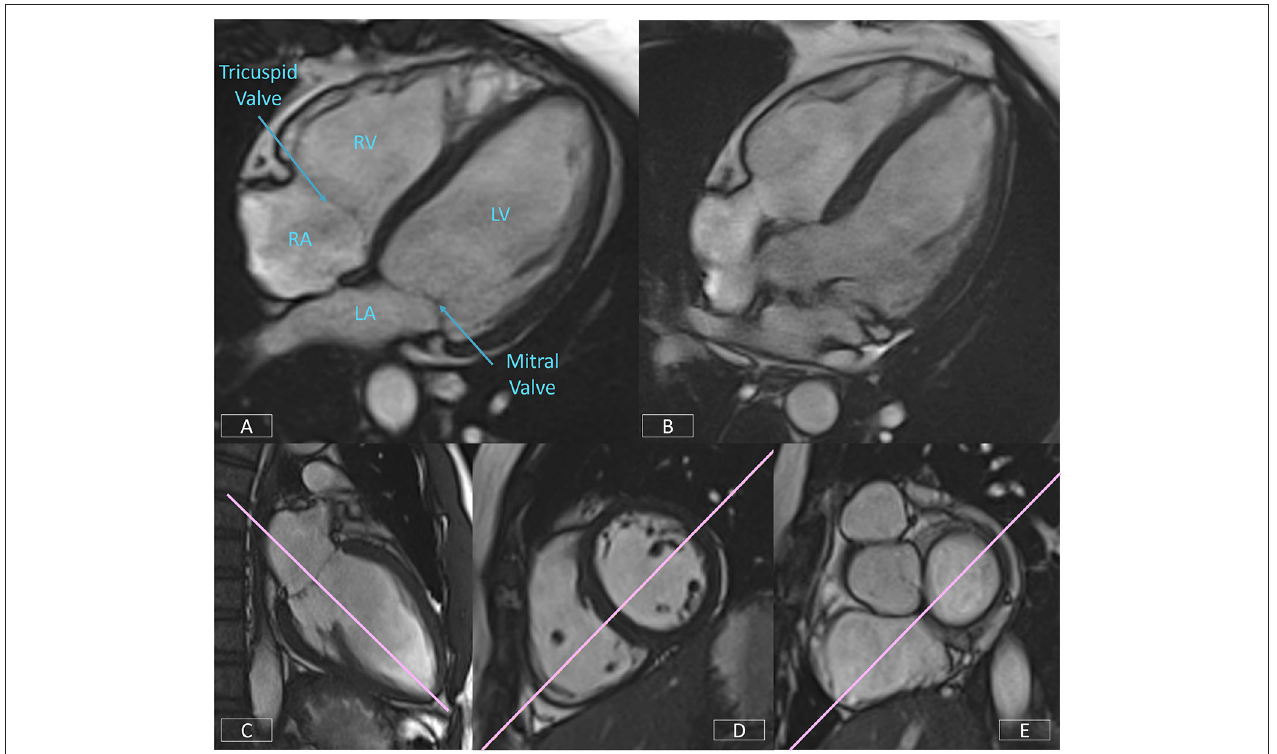
FIGURE 8 | Well-positioned 4-chamber view (A) demonstrating mitral and tricuspid valves, right and left atria, and ventricles. Incorrect prescription (B) with the slice plane prescribed through the LV OT. Accurate positioning of the 4-chamber view requires the use of three views, the LV VLA view (C) , mid-ventricular LV SAX slice (D) , and the basal LV SAX slice (E) .